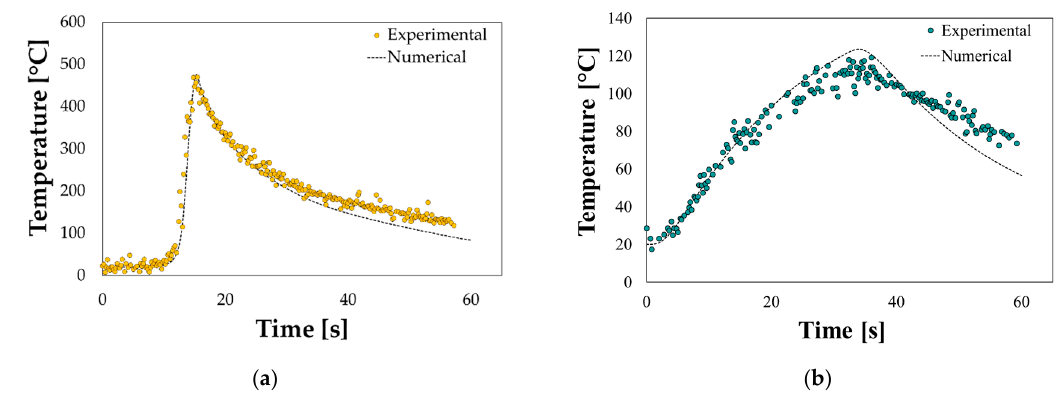
Figure 14. LHT numerical simulation (FR = 4 mm/s): temperature distribution after ( a ) half and ( b ) at the end of the heating.